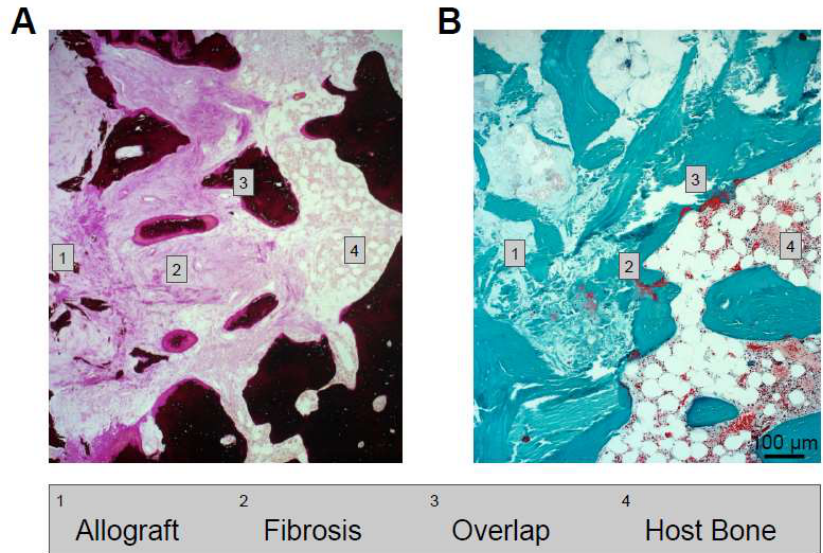
Figure 6. Histological sections demonstrating the interface of the allograft and host bone that is composed of different zones, including fibrosis and overlap (1–4). ( A ) Von Kossa staining. ( B ) Trichrome Goldner staining.